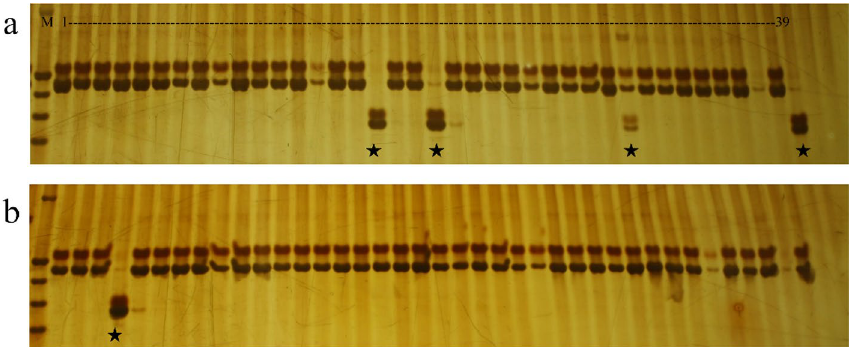
Figure 3. Detection results of RM24 marker in some single plants of Xianggu under different seed viability. ( a , b ) represent the seed with the germination rates of 90% and 30%, respectively. ★ represents the specific single plant under SSR marker